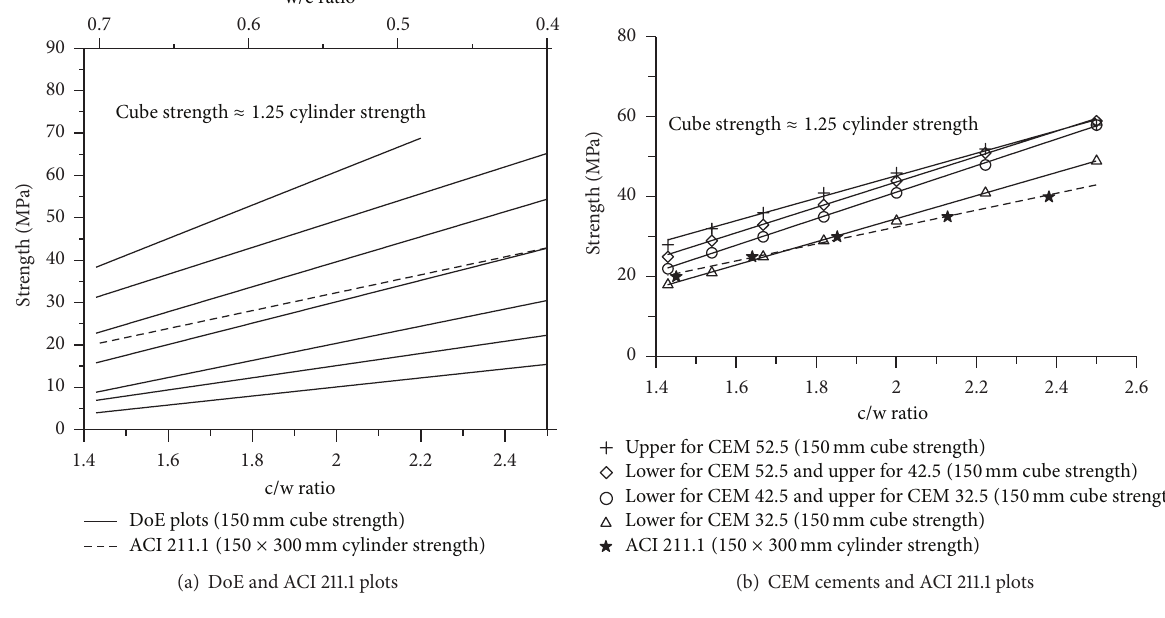
Figure 1: Relationship between the c/w ratio and the strength of concrete